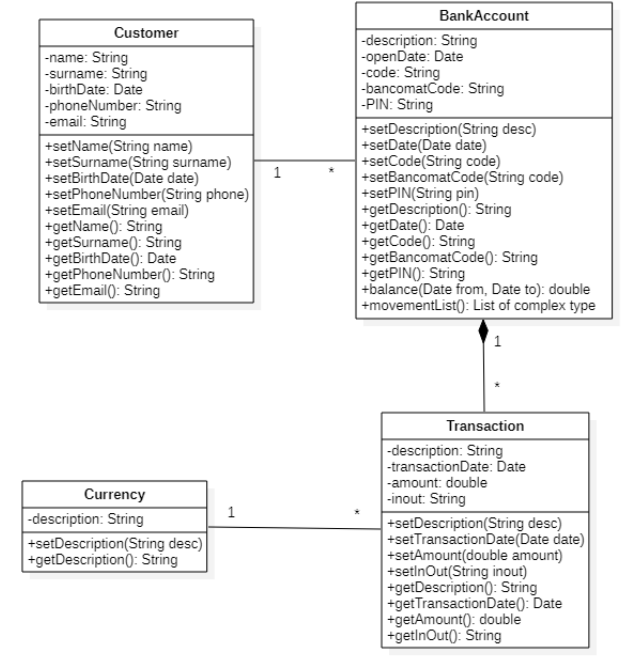
Figure 15. The UML class diagram of reference. Table 3. An excerpt of the metadata to be inserted into the corporate repository.